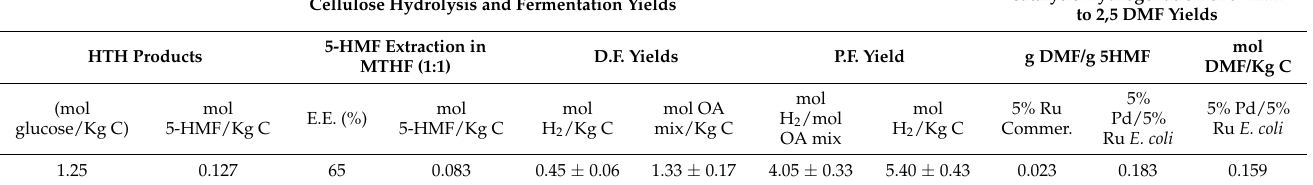
Table 3. Cellulose hydrolysis, fermentation and hydrogenation yields of products. Glucose and 5-HMF yields from cellulose via hydrothermal hydrolysis are reported previously in this study. 5-HMF extraction in MTHF, efficiency and yields are from [48,53]. H 2 -dark fermentation yields are reported in this study and from [48]. H 2 -photo-fermentation H 2 yields are from [48,49,56] and R.L. Orozco (unpublished work). Catalytic hydrogenation of 5-HMF to 2,5 DMF yields are taken as per in [57]. Hydrothermal Hydrolysis (HTH); Extraction Efficiency (E.E.); Dark Fermentation (D.F.); Photo-fermentation (P.F.); Cellulose (C); Commercial (commer.). STDEV with n = 3 (number of experiments). Values without STDEV are average of two